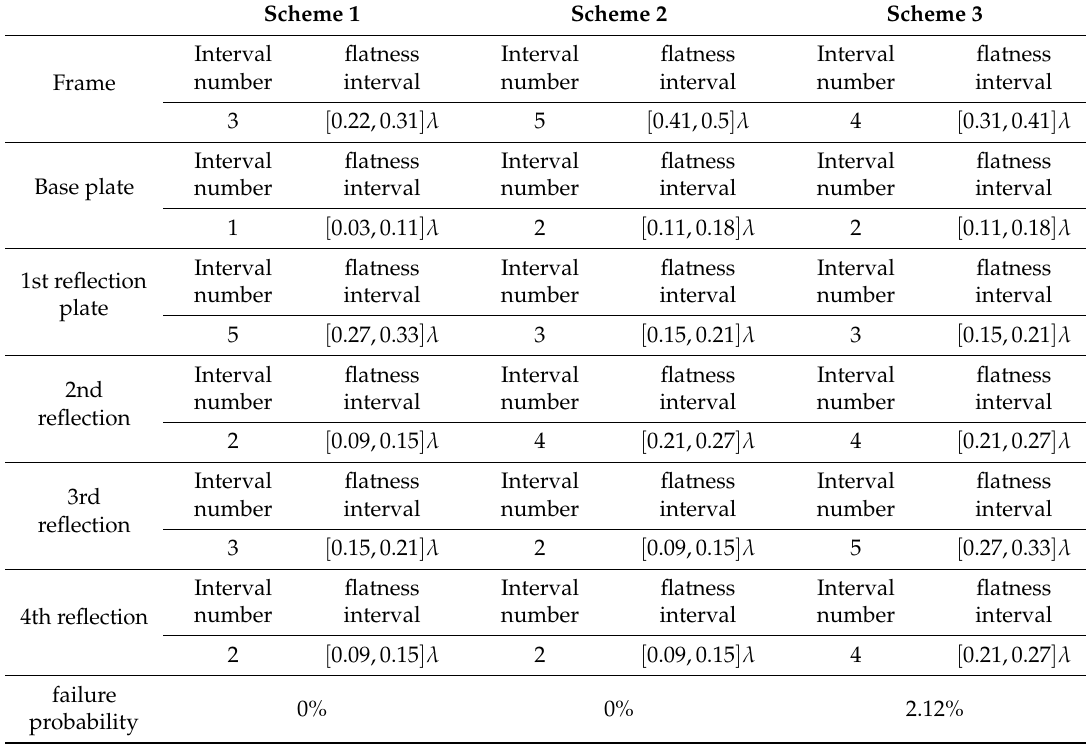
Table 1. Three kinds of combinations for the array